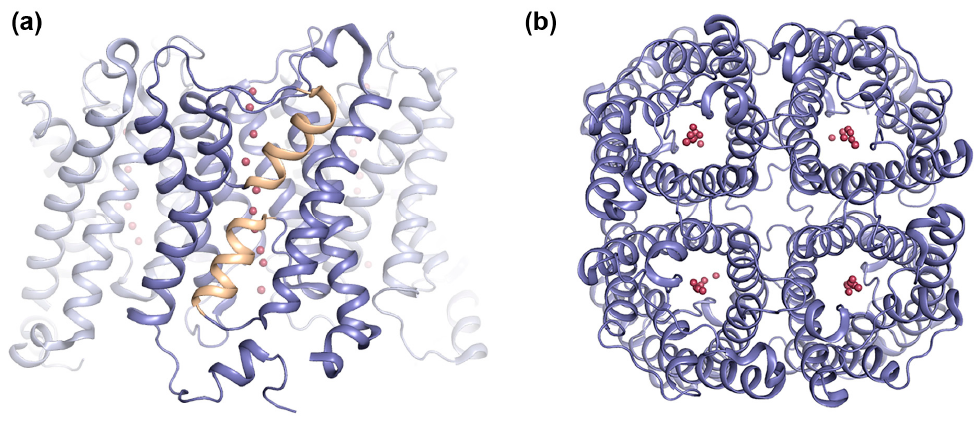
Figure 1. Overall structure of aquaporins (AQPs). Crystal structure of human AQP5 (PDB code 3D9S) showing the AQP tetramer viewed: ( a ) parallel to the membrane and ( b ) from the extracellular side. The AQP5 tetramer is shown in blue ribbon-representation with half-membrane spanning helices formed by loops B and E colored yellow. Water molecules in the pore are shown as red spheres.